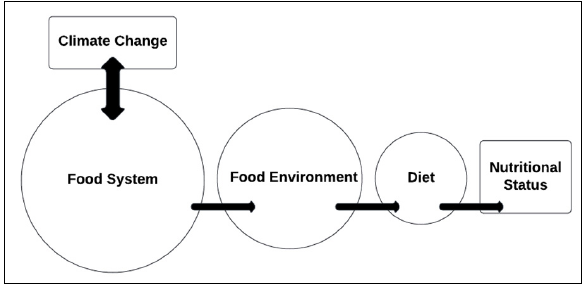
Figure 1: Conceptual model of the food environment typology and its elements driving the syndemic. Nutritional status is determined by